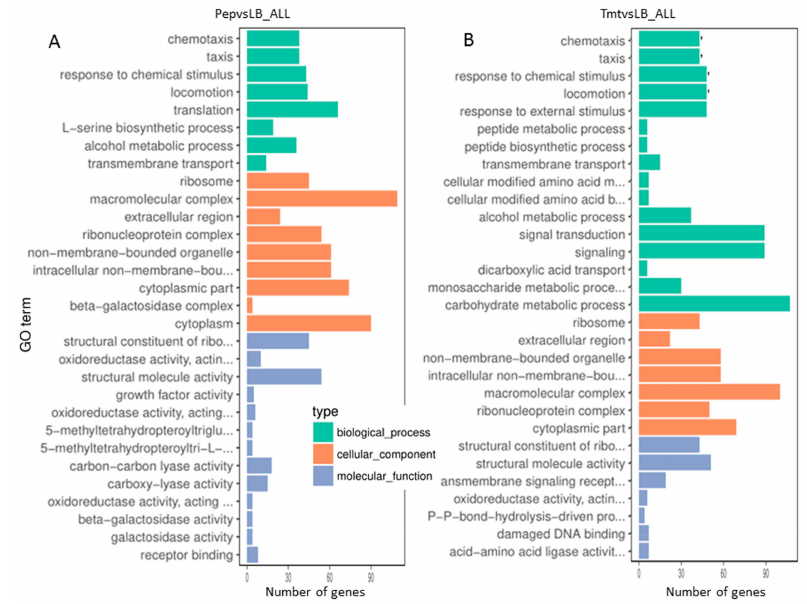
Figure 2. Comparing functional annotations between di ff erent samples ( A ) Comparable group: Pep and LB; ( B ) Comparable group: Tmt and LB; The green bars represent biological process; orange bars represent cellular component; purple bars represent molecular function.